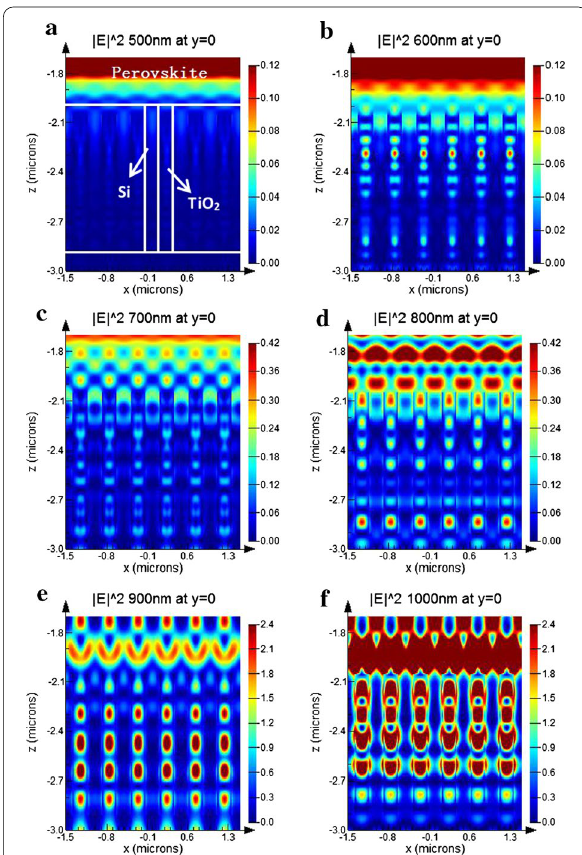
Fig. 5 Electric field intensity distribution of tandem solar cells at fixed height 900 nm a wavelength at 500 nm, b wavelength at 600 nm, c wavelength at 700 nm, d wavelength at 800 nm, e wavelength at 900 nm, and f wavelength at 1000 nm